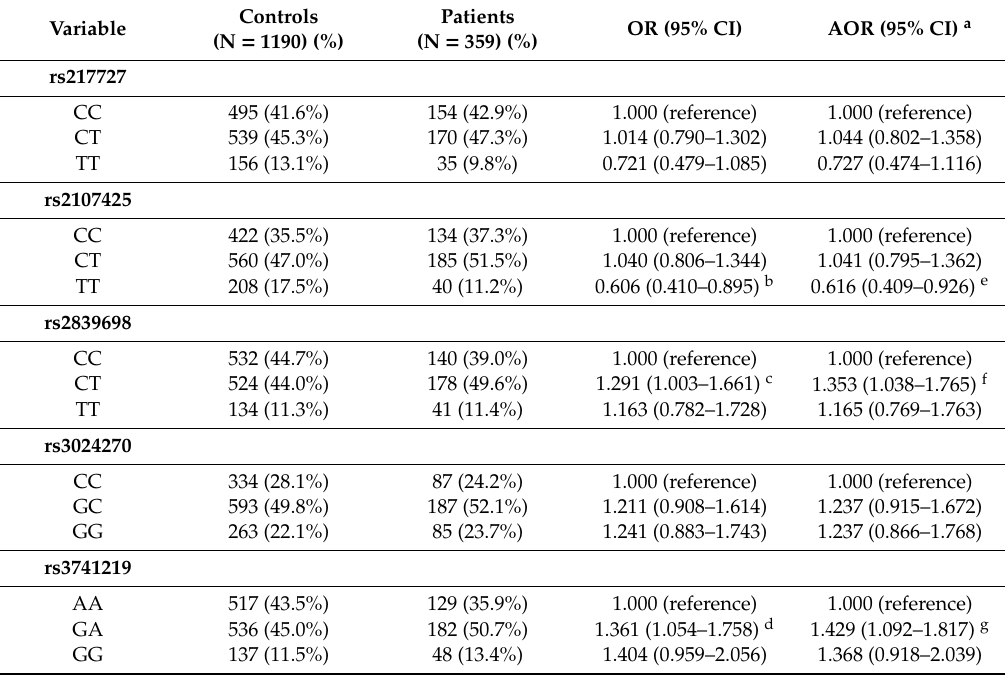
Figure 1. Genomic structure of human H19 and locations of the single-nucleotide polymorphisms (SNPs) examined in this study. The genome structure of human lncRNA H19 is within the region of 1995 K–2000 K bp of chromosome 11 for the GRCh38.p12 primary assembly. H19 contains 5 exons as represented by boxes in blue and flanking introns shown by lines. miR-675, which is embedded in the 1st exon of H19, is indicated by the red box. The five SNPs tested, rs2107425 (in the promoter region), rs2839698 (exonic), rs3024270 (intronic), rs217727 (exonic) and rs3741219 (exonic), are shown above the scale. Table 2. Genotypic frequency of H19 SNP in HCC and normal